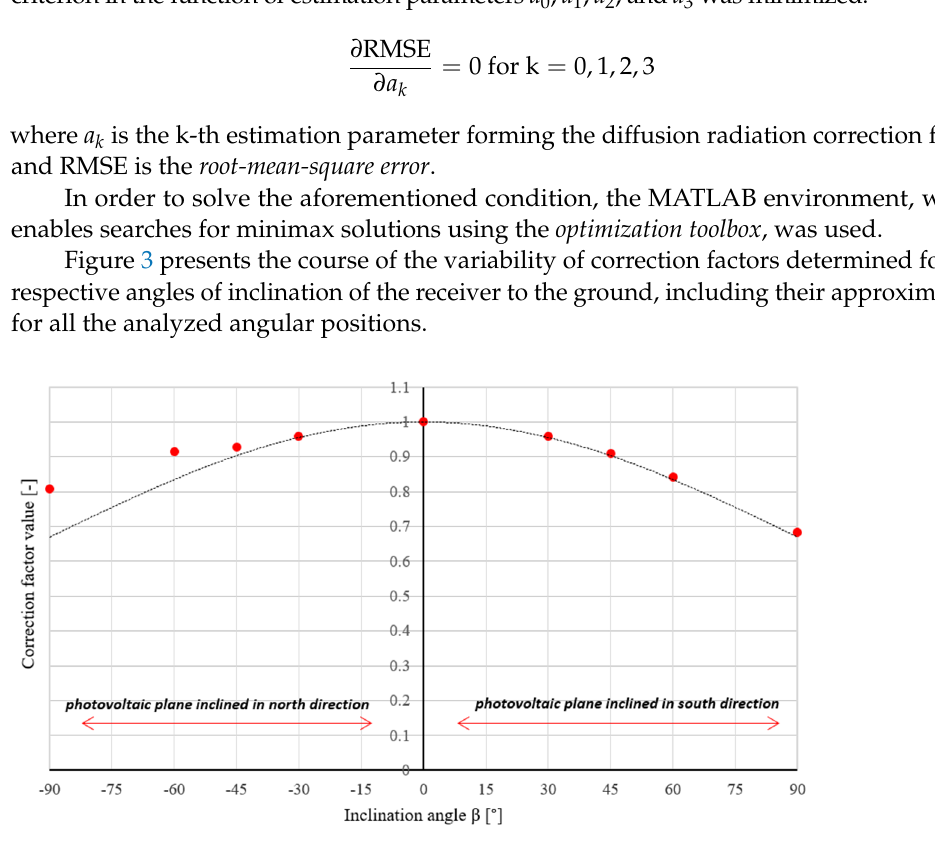
Figure 3. Variability of values of the correction factor in the function of the angle of inclination of the plane of the photovoltaic module and the determined approximating function for the entire angular range.